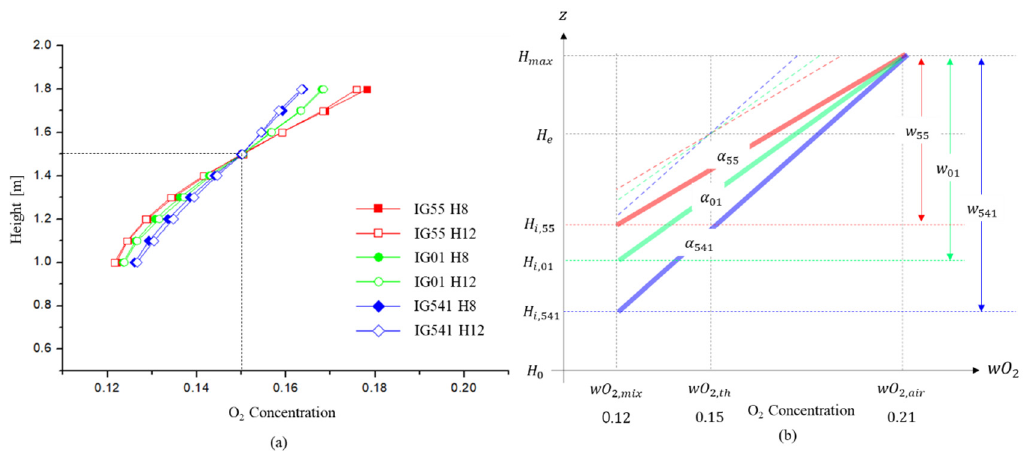
Figure 9. Comparison of the interface slope α according to the number of leakage holes of each agent: ( a ) Comparison of the interface slope α for each agent when the O 2 concentration at the specified height H e is 0.15; ( b ) comparison of the maximum interface thickness ω max of each agent when the O 2 concentration at the maximum height H max of the enclosure is the O 2 concentration of air.